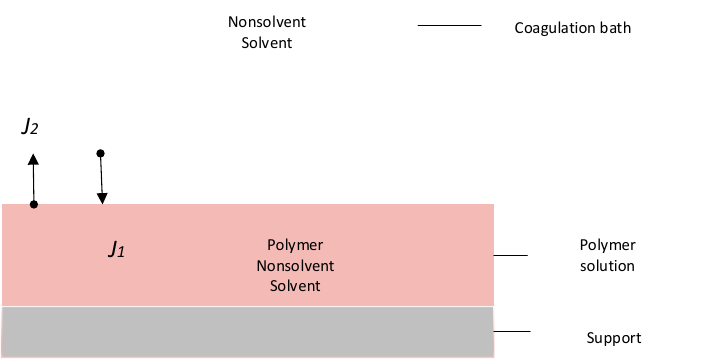
Figure 22. Schematic representation of a film/bath interface. Components: non-solvent (1), solvent (2). The CARO High Performance Anisotropic Membrane prepared by the Immersion Precipitation Method is one of the most critical advancements in desalination technology.